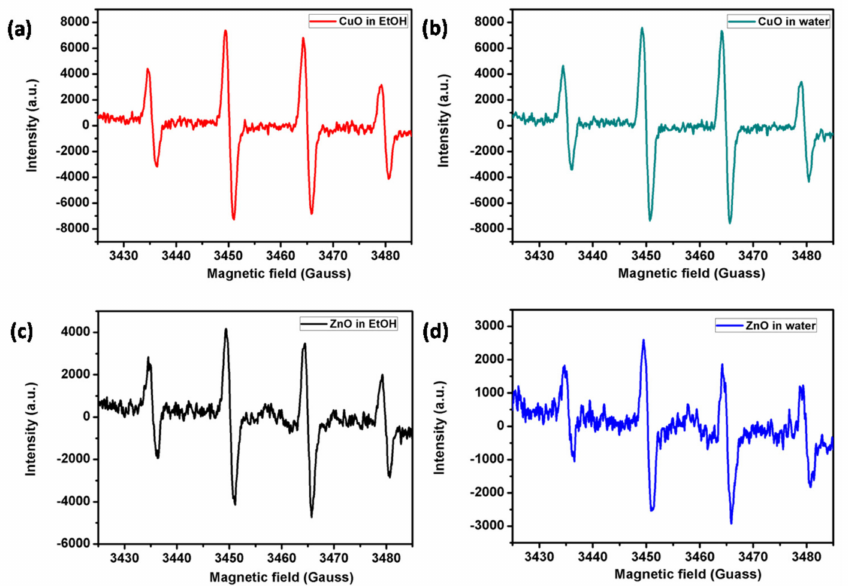
Figure 4. ROS generation by CuO and ZnO NP-coated bandages synthesized in ethanol ( a , c ) or water ( b , d ) in the presence of DMPO